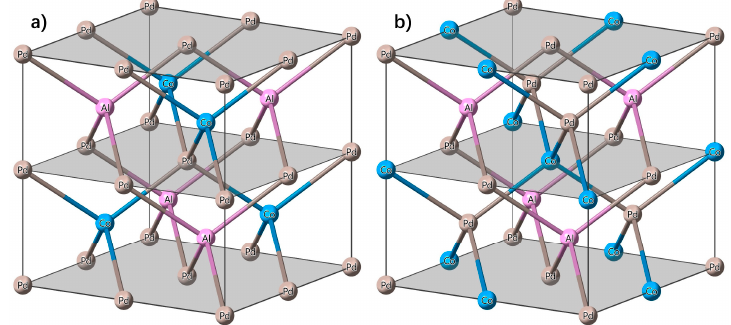
Figure 1. Schematic illustrations of the atomic configurations for the full Heusler compound Pd 2 CoAl in ( a ) L 2 1 -type and ( b ) XA -type structures.